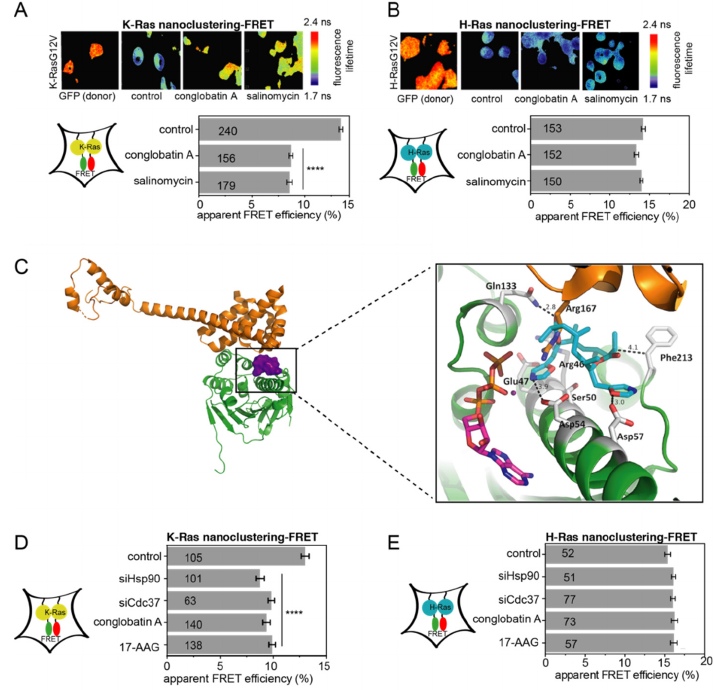
Figure 1. Conglobatin A selectively targets K-Ras via the inhibition of Hsp90/Cdc37. ( A , B ) FLIM- FRET images of HEK cells transfected with FRET-pairs of mGFP-/mCherry-K-RasG12V ( A , top) or mGFP-/mCherry-H-RasG12V ( B , top). The labelling indicates donor-only control or treatments. A decrease in the fluorescence lifetime indicates an increase in FRET due to nanoclustering. The transfected cells were treated with 0.1% DMSO vehicle control, 2 µ M conglobatin A, or 1.3 µ M salinomycin for 24 h. The nanoclustering-FRET analysis by treatment for K-RasG12V ( A , bottom) or H-RasG12V ( B , bottom). The numbers in the bars indicate the number of analyzed cells; n = 3 independent biological repeats. ( C ) Conglobatin A (purple surface) was docked into the crystal structure of human N-Hsp90 (green; PDB ID 3T0Z). The docked complex was overlaid on top of the crystal structure of yeast N-Hsp90 in a complex with human Cdc37 (PDB ID 1US7), of which only Cdc37 is depicted (orange). The magnification shows the details of how conglobatin A (cyan sticks) sterically blocks and disturbs critical interactions, notably between Glu47 of Hsp90 (gray sticks) and Arg167 of Cdc37 (orange sticks) at the interface of the complex. ATP is shown as magenta sticks, and magnesium is shown as a deep purple sphere. The polar interactions between conglobatin A and Hsp90 are shown as dashed lines, with distances in Ångströms. ( D , E ) The K-RasG12V- ( D ) and H-RasG12V- ( E ) nanoclustering-FRET in HEK cells co-transfected with mGFP- and mCherry- tagged RasG12V, together with 50 nM siRNA Hsp90, siRNA Cdc37, or 50 nM scrambled siRNA for compound/vehicle (control) treated samples. The next day, the cells were treated for 24 h with 0.1% DMSO vehicle control, 2 µ M conglobatin A, or 2 µ M 17-AAG. The numbers in the bars indicate the number of analyzed cells. The number of independent biological repeats n = 3 for K-Ras and n = 1 for H-Ras. **** p <